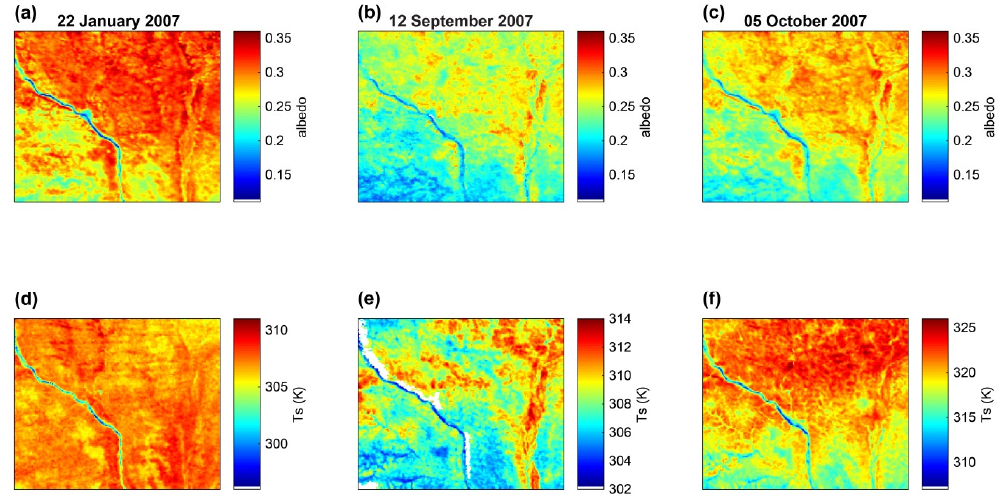
Figure A2. Maps of MODIS TERRA albedo (top) and Ts (bottom) corresponding to ETd maps of Figure 10 on a dry day (22 January 2007; a , d ), a wet day (12 September 2007; b , e ), and a transition day (05 October 2007; c , f ). White pixels mean non-available